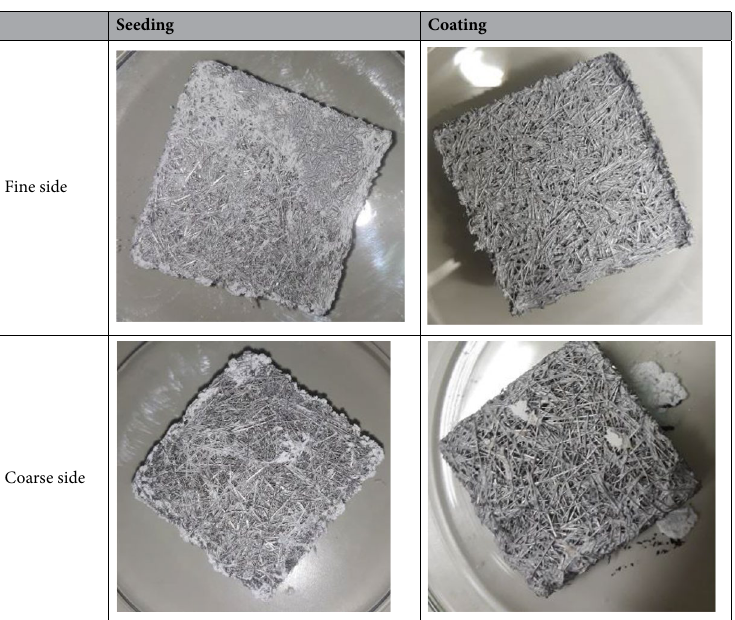
Table 3. SrCl2 seeding and coating on aluminium fibre structures.